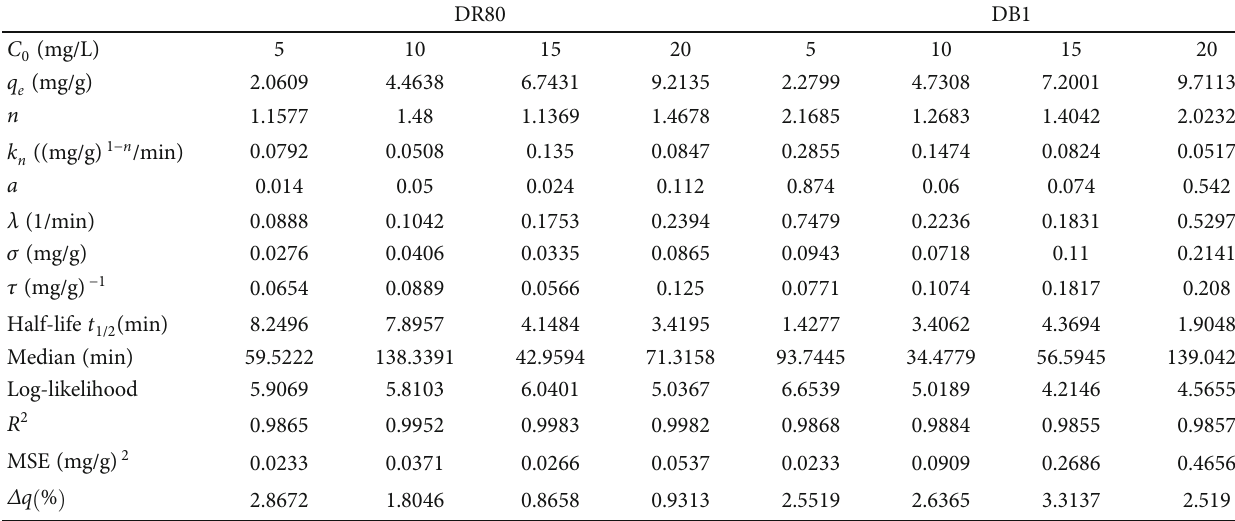
Table 1: Estimated values of the parameters of the TOU model and goodness-of- fi t measures of adsorption kinetics for DR80 and DB1 removal using Pec-Ca for initial dye concentrations C 0 of 5, 10, 15, and 20 mg/L.